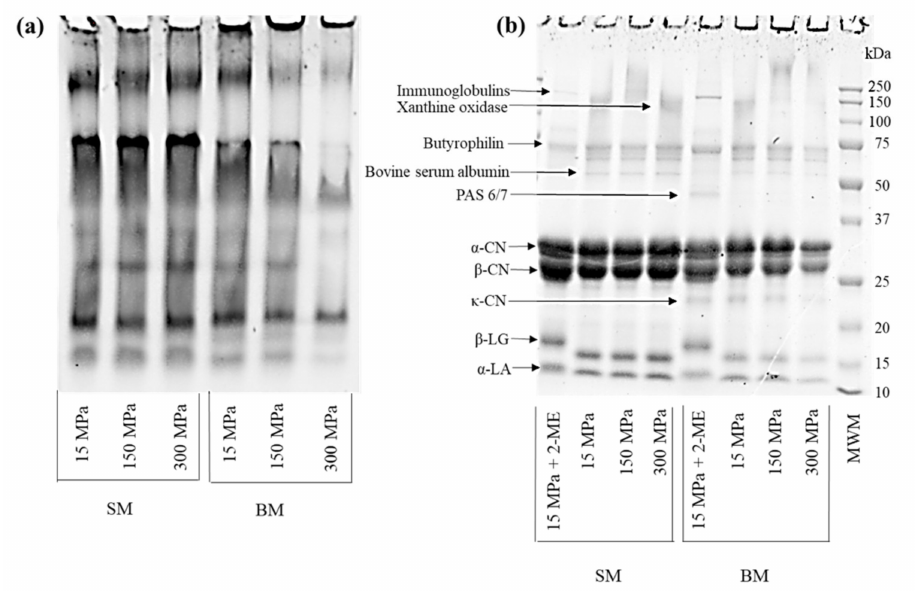
Figure 2. Acrylamide gels (12%) of skimmed milk (SM) and buttermilk (BM) following pressure treatments (( a ) native polyacrylamide gel electrophoresis (PAGE) pattern, and ( b ) sodium dodecyl sulfate (SDS)-PAGE pattern under reducing (lanes 1 and 5) and nonreducing conditions). PAS 6/7 = periodic acid Schiff 6/7, MWM = molecular weight markers, 2-ME =